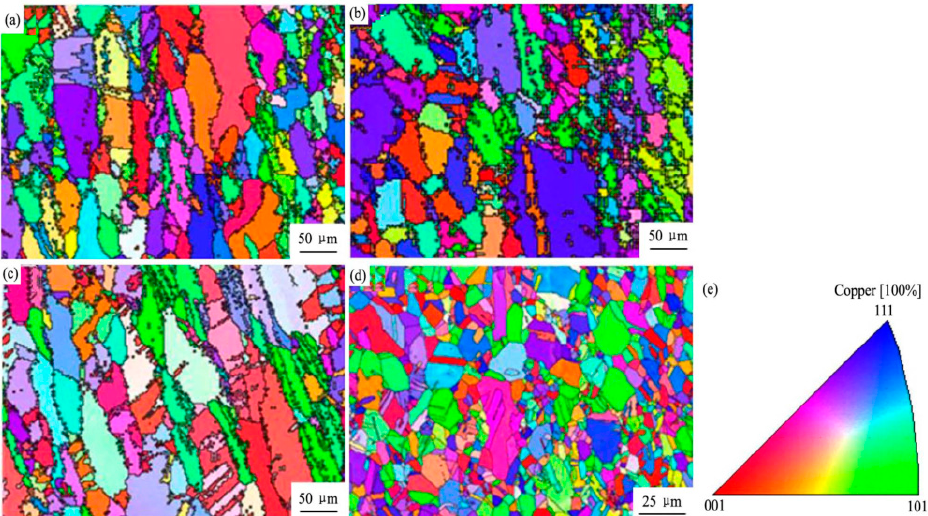
Figure 5. EBSD IPF maps of annealed Cu-Ag-RE samples with different Ce concentrations: ( a ) 0.05 wt.%; ( b ) 0.1 wt.%; ( c ) 0.2 wt.%; ( d ) 1.0 wt.%; ( e ) IPF coloring [15]. Reprinted/adapted with permission from Ref. [15]. Copyright year 2017, Elsevier.